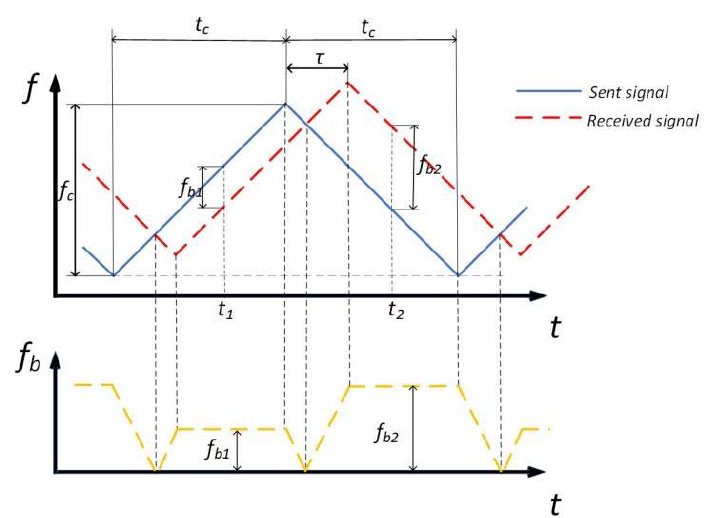
Figure 2. The curve of the beat frequency versus time.